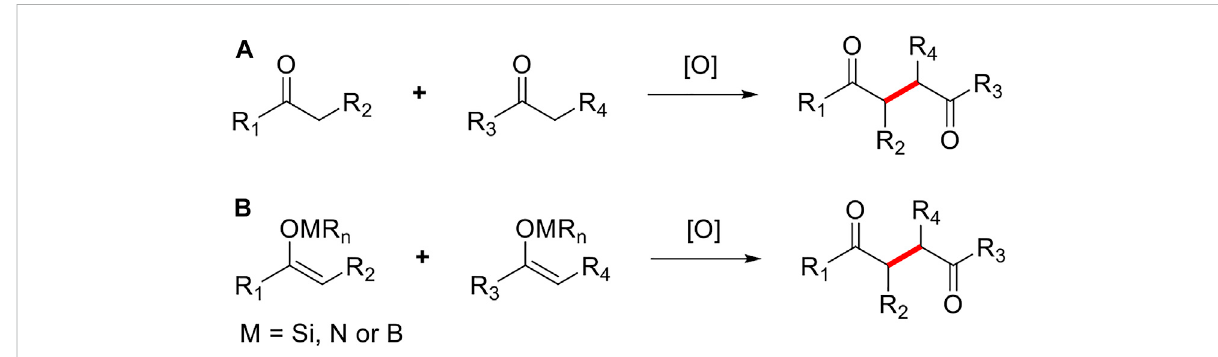
Types of enol oxidative coupling reaction.